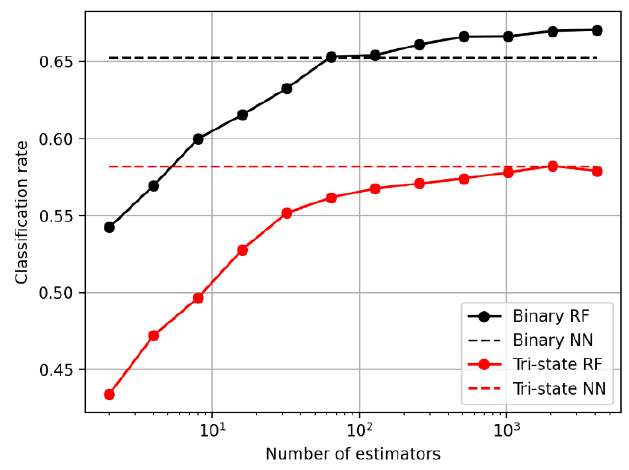
Figure 6. Tuning the number of trees (estimators) in the random forest binary and tri-state classifiers for the health change predictor without taking into account the previous health. The best neural network binary and tri-state performance is also shown for comparison.